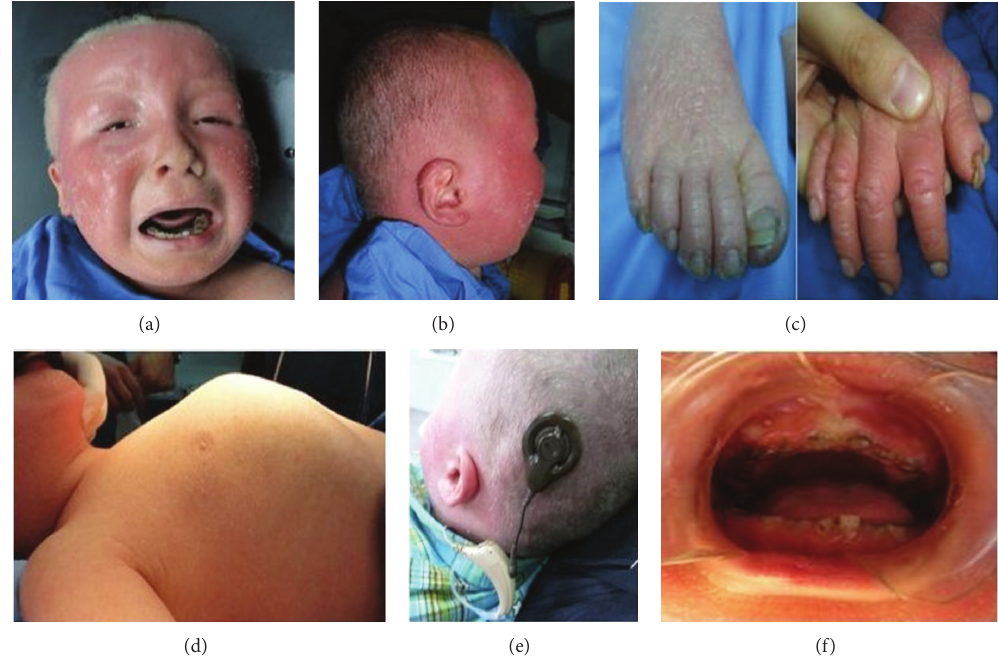
Figure 1: (a) Erythematous hyperkeratotic patches over the skin and the eyebrows and eyelashes are sparse in the photograph of this case. (b) Erythematous hyperkeratotic patches over the skin and the eyebrows and eyelashes are sparse in the photograph of this case. (c) View of hand, foot, and nails. (d) Pigeon chest. (e) Cochlear implant. (f) Intraoral view before the treatment.